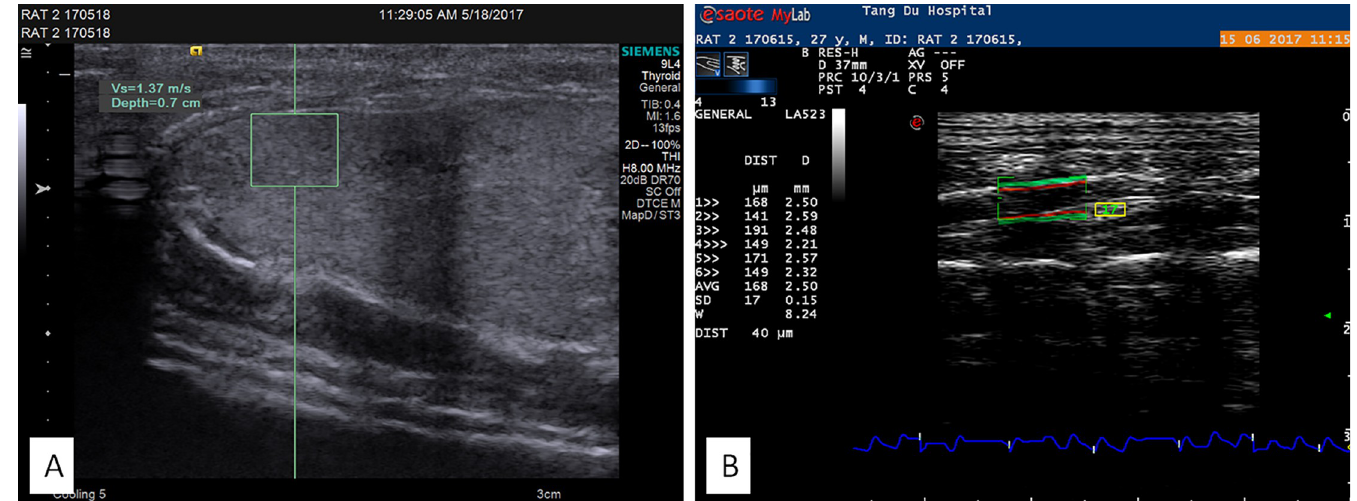
Fig 2. A. ARFI elastography was performed to measure the rat liver stiffness; B. Radio frequency ultrasound imaging was performed to measure the abdominal aortic elasticity parameter and the pulse wave velocity (PWV) of the rats.